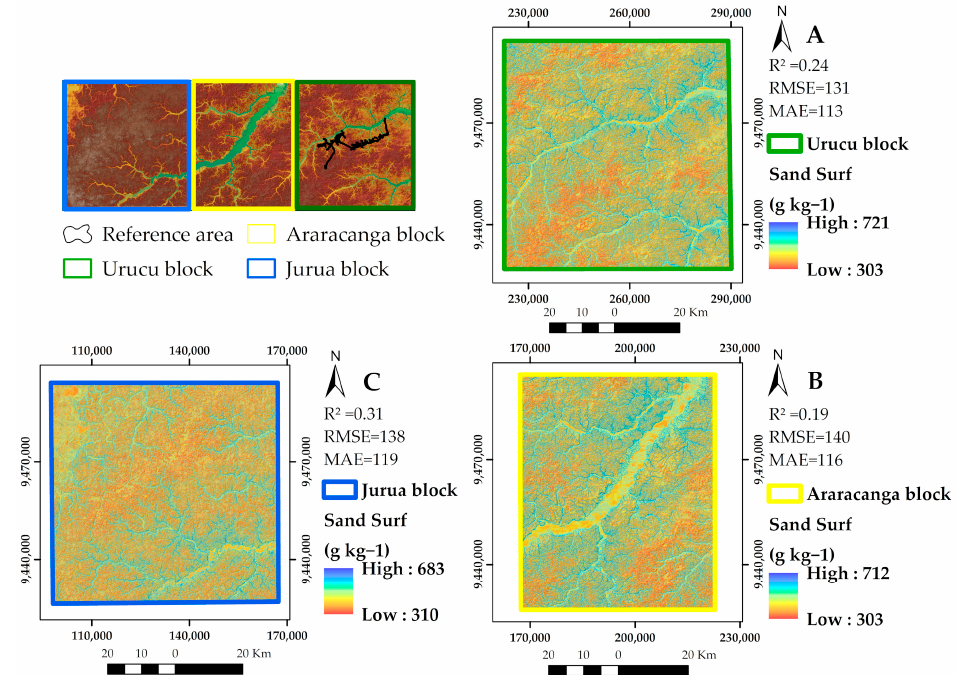
Figure 9. Map of the sand content at the surface layer. (Map generated using Reference Area approach, Random Forest, and Previous Covariate Selection), ( A ) Urucu block, ( B ) Araracanga block, ( C ) Jurua block.